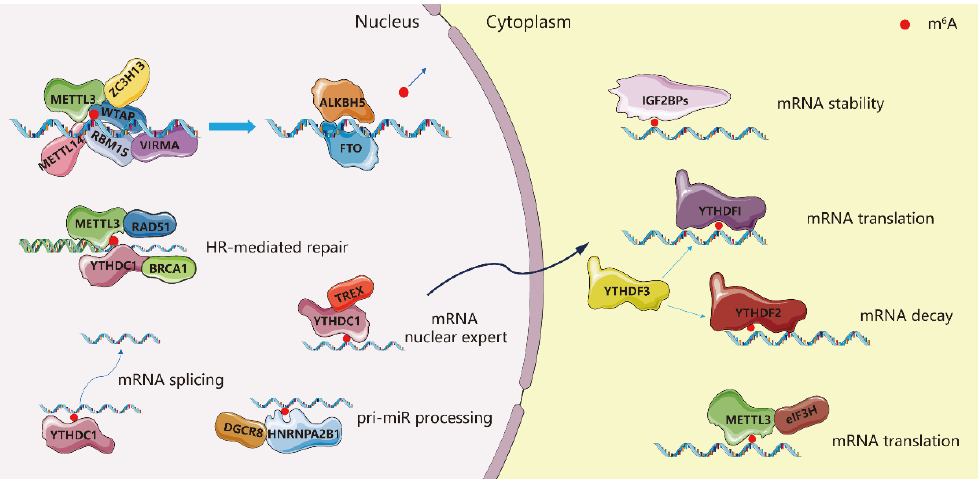
Figure 1. METTL3-dependent biological functions in cells.